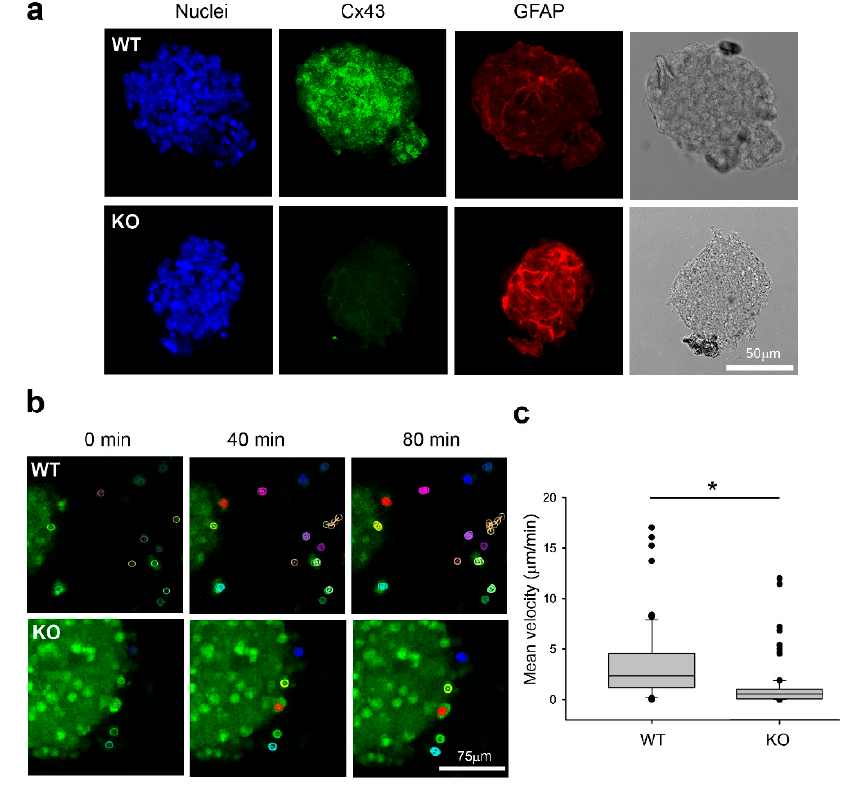
Figure 3. Elimination of Cx43 in mouse progenitor cells reduces GBM8 invasion. ( a ) Wild-type (WT) and Cx43 knockout (KO) spheroids were co-stained with anti-Cx43 and anti-GFAP antibodies. GFAP was detected in both WT and KO spheroids. In contrast, the punctate staining of Cx43 was only detected in WT but not the KO spheroids, confirming successful knockout of Cx43 in the mouse progenitors. Scale bar 50 μ m ( b ) 3D cell tracking was carried out using the Fiji plugin, MTrackJ. Representative images showing cell movement in two 40-min periods. The track of a single cell is denoted by a colored lane in a 3D projection. Each circle represents the x,y,z location of the cell at a time point from 0 to 40 min, and from 0 to 80 min. The difference between 40 and 80 min track illustrates the movement of cells during this time interval. Note that the movement of a cell in the z direction will not be apparent in these 2D representative images. Scale bar 75 μ m ( c ) Mean velocity of GBM8 in WT and KO mouse spheroids. The data shown here are pooled from at least three experiments. Data were analyzed by Student’s t test. * P < 0.05. 3. Discussion The tissue environment that envelops the glioma cells not only affects the dissemination of cancer cells, but it also influences the susceptibility of cancer cells to therapeutic intervention [24]. One prominent feature of the glioma microenvironment is the presence of a large number of reactive astrocytes exhibiting increased GFAP and Cx43 expression in the peri-tumor region [15,25–27]. In this environment, Cx43-mediated GJIC is expected to occur between glioma cells, between astrocytes and heterocellularly between glioma cells and astrocytes. In the latter case, Cx43 has been shown to be a facilitator in tumor invasion by allowing transfer or exchange of signaling molecules such as miRNA or cGAMP between cancer cells and astrocytes [16,28]. An early study indicates that 90% of recurrent gliomas occur within 2 cm of the resected tumor [29]. Therefore, we developed a 3D platform with the capacity to quickly quantify the invasion of patient-derived glioma cells into normal tissue, focusing on the invasive niche [30] at the tumor– stromal interface. In addition, a tumor organoid culture will have the advantage of having cellular complexities that better assess therapeutic response [31]. As a proof-of-principle study, we